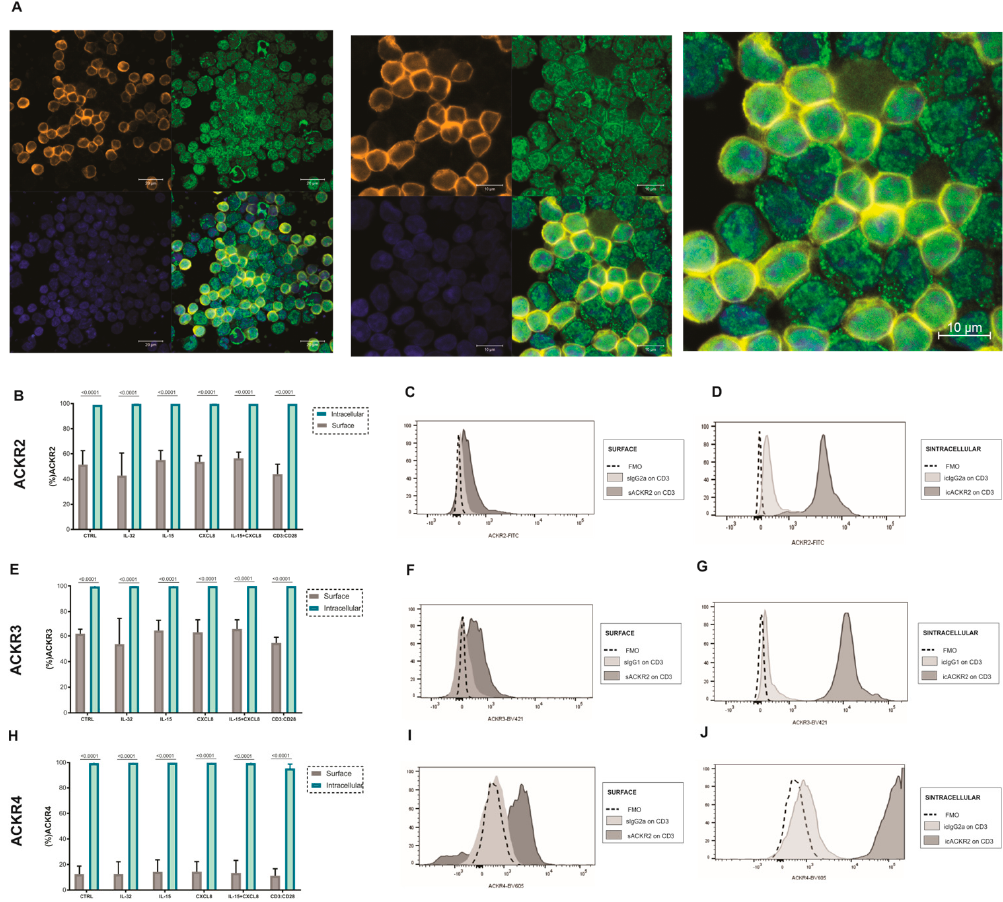
Figure 4. Surface and intracellular expression of ACKRs after different stimuli. Atypical chemokine receptor expression assessed by flow cytometry and confocal microscopy in lymphocytes obtained from peripheral blood of healthy donors. ACKR2 ( A ) confocal microscopy of T cell stained with ACKR2-FITC (green), CD3-PE-CF594 (orange) and DAPI (blue) for nuclei (40 × and 62 × ). ( B ) Graph comparing ACKR2 expression after different stimuli on the lymphocytes surface and in the intra- cellular compartment, ( C , D ) Representative data showing an overlaid histogram of FMO, IgG2a and ACKR2 surface and intracellular expression. ACKR3 ( E ) graph comparing ACKR3 expression after different stimuli on the lymphocytes surface and in the intracellular compartment. ( F , G ) Repre- sentative data showing an overlaid histogram of FMO, IgG1 and ACKR3 surface and intracellular expression. ACKR4 ( H ) graph comparing ACKR4 expression after different stimuli on the T lympho- cytes surface and in the intracellular compartment. ( I , J ) Representative data showing an overlaid histogram of FMO, IgG2a and ACKR4 surface and intracellular expression (n = 4). 3.5. ACKRs mRNA Expression on T Cells Was Described on